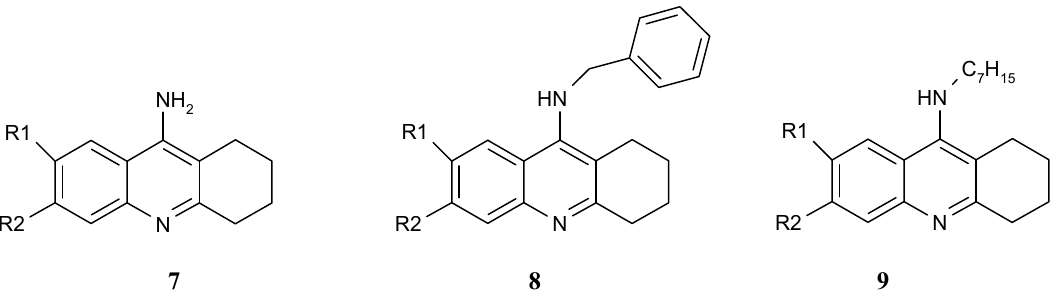
Figure 3. 9-Amino-1,2,3,4-tetrahydroacridine derivatives 7 , 8 , 9